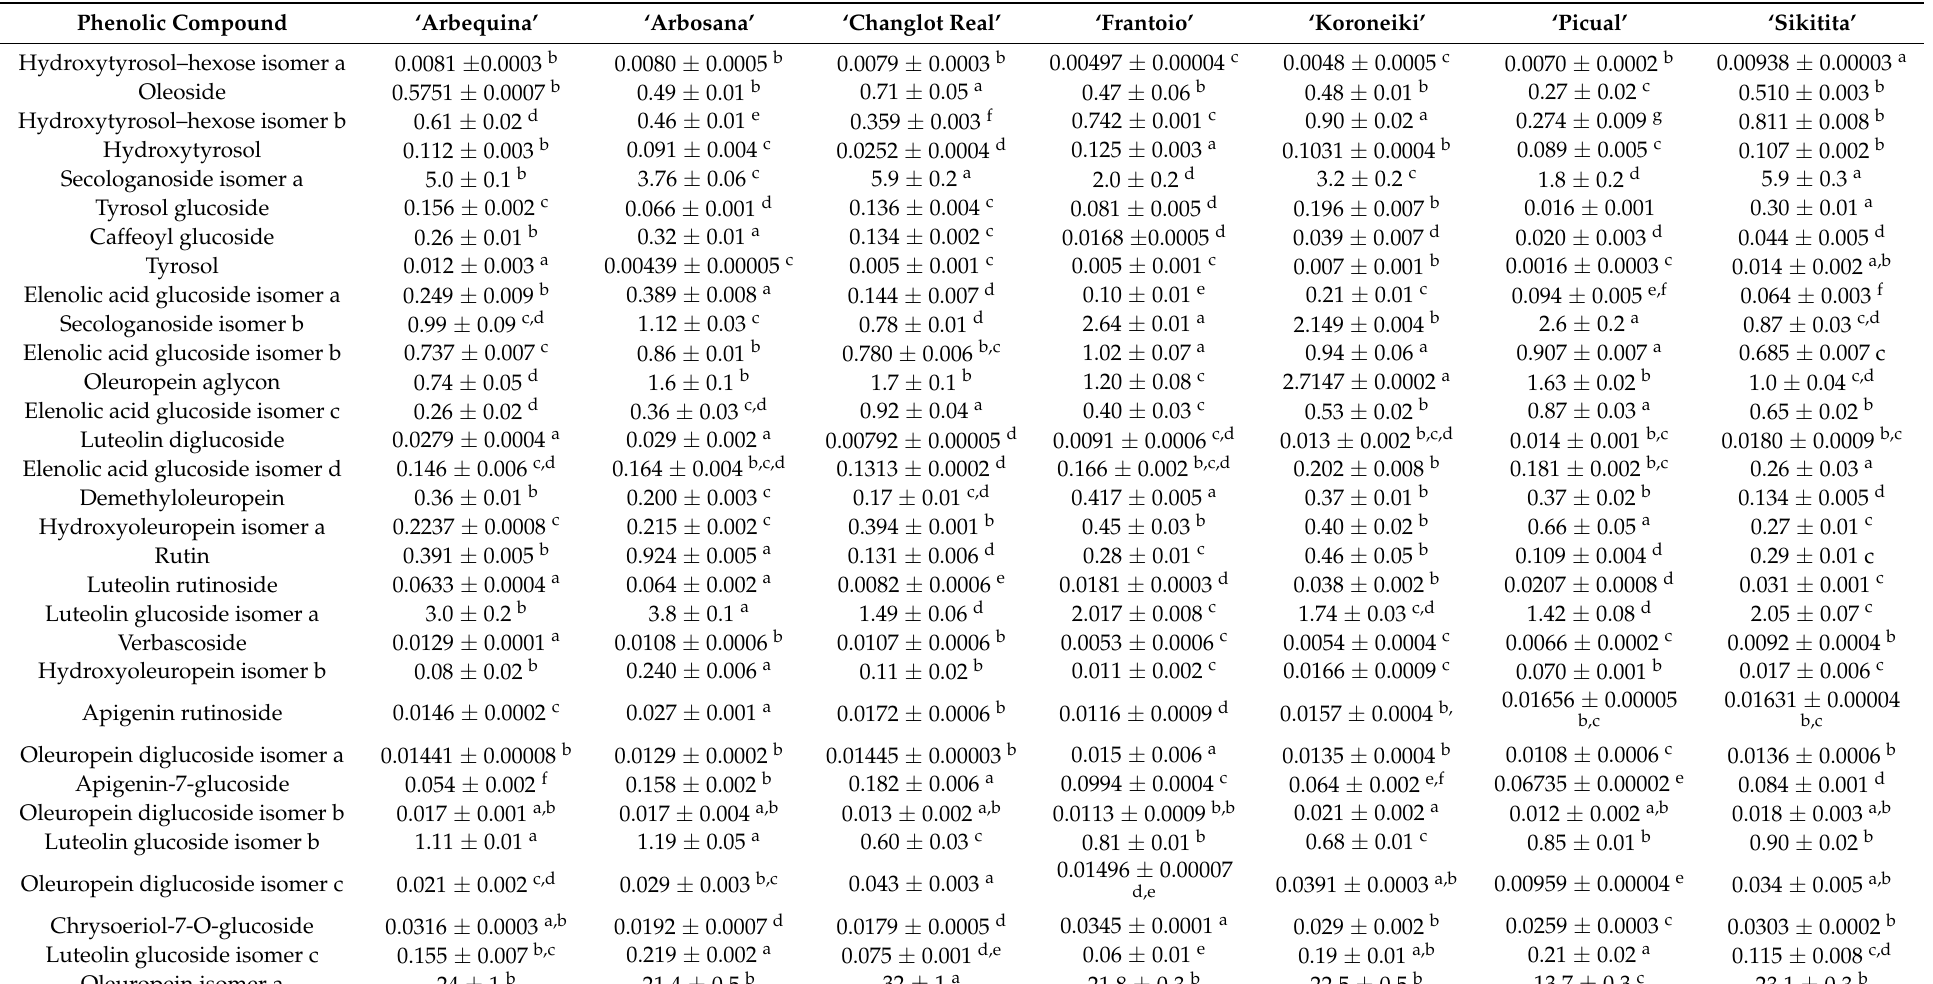
Table 4. Quantification of phenolic compounds obtained at optimum sonotrode conditions in different olive leaf cultivars. Results are expressed as mean ± standard deviation in mg g − 1 dry matter of olive leaves. Different letters in the same line indicate significant differences among the